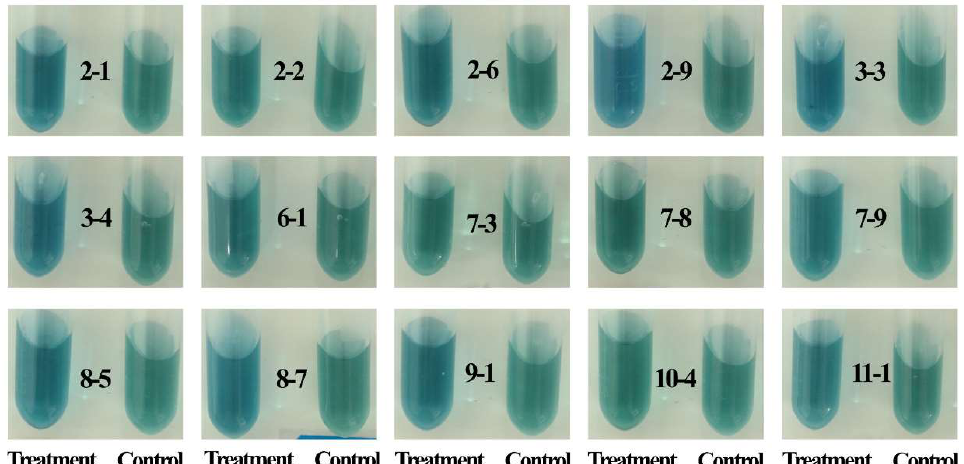
Figure 4. N-fixation ability of representative strains originated from the newly reclaimed land amendmentwith different organic fertilizers.